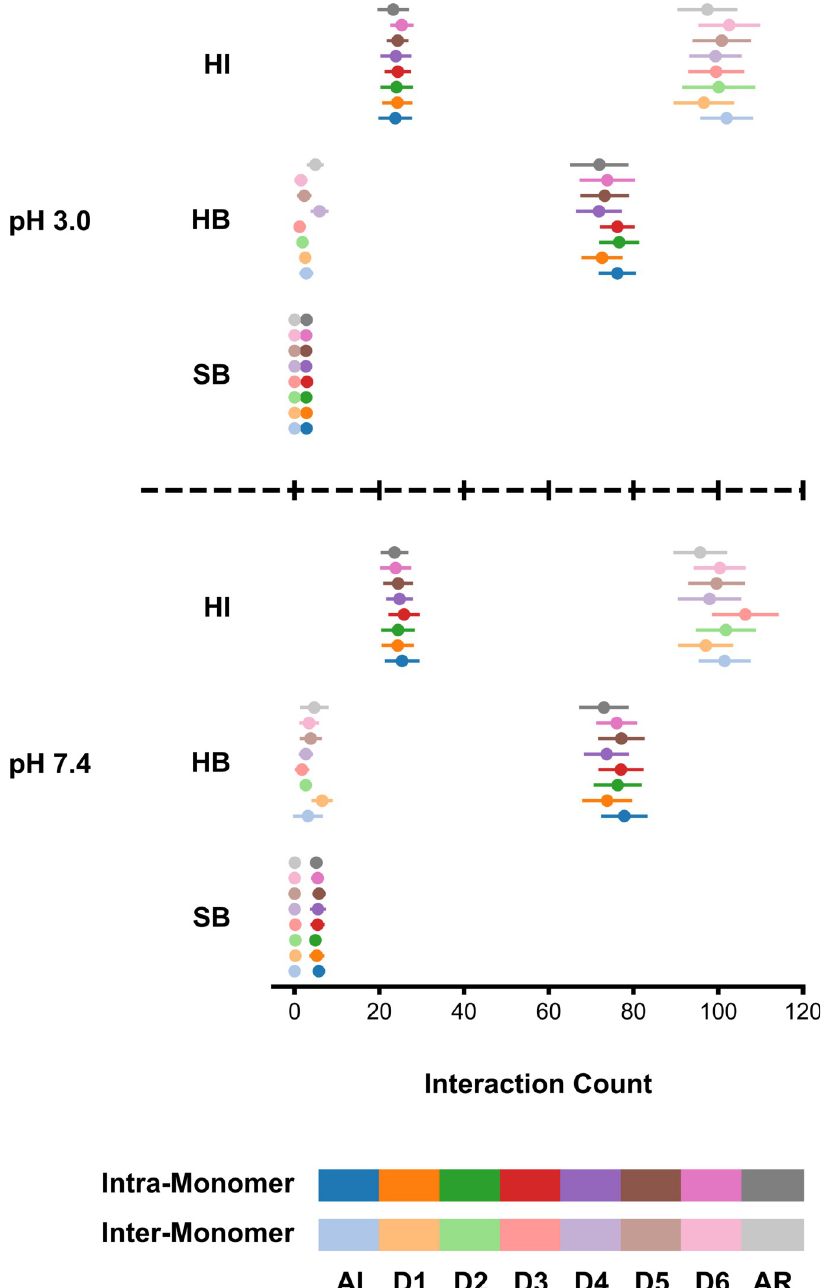
Fig 6. Counts of hydrophobic interactions (HI), hydrogen bonds (HB), and salt bridges (SB). pH 3.0 and 7.4 are displayed on the top and bottom, respectively. The disulfide state is indicated by the legend at the bottom of the figure. Inter-monomer data is presented as the average of the three replicates ( n = 3), whereas intra-monomer data is presented as an average taken across both of the monomeric units for each of the three replicates ( n = 6). The last 10% of the trajectories was utilized for the analyses. Error bars are ± standard